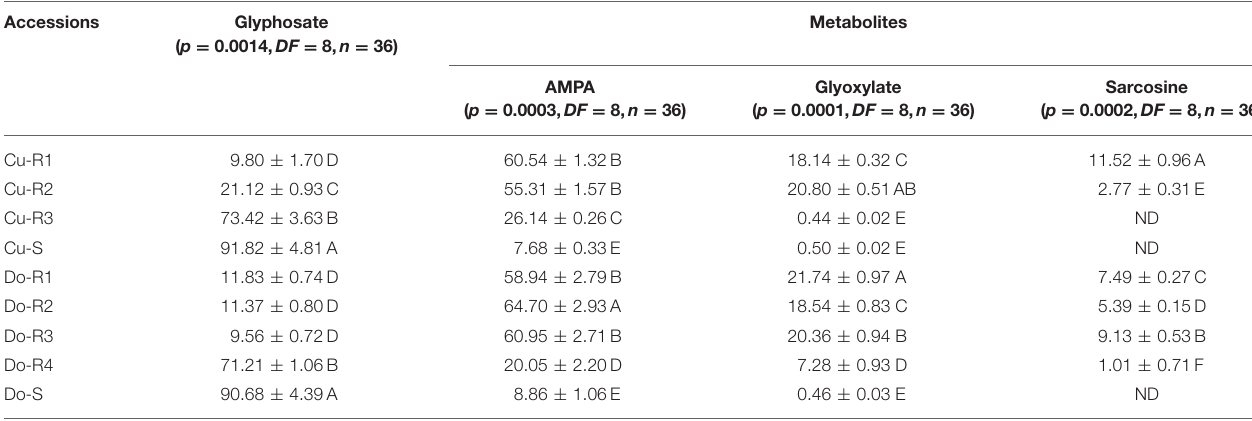
TABLE 4 | Glyphosate metabolism expressed as a percentage of total glyphosate and its metabolites in P. hystherophorus susceptible and resistant-glyphosate accessions at 96 HAT.